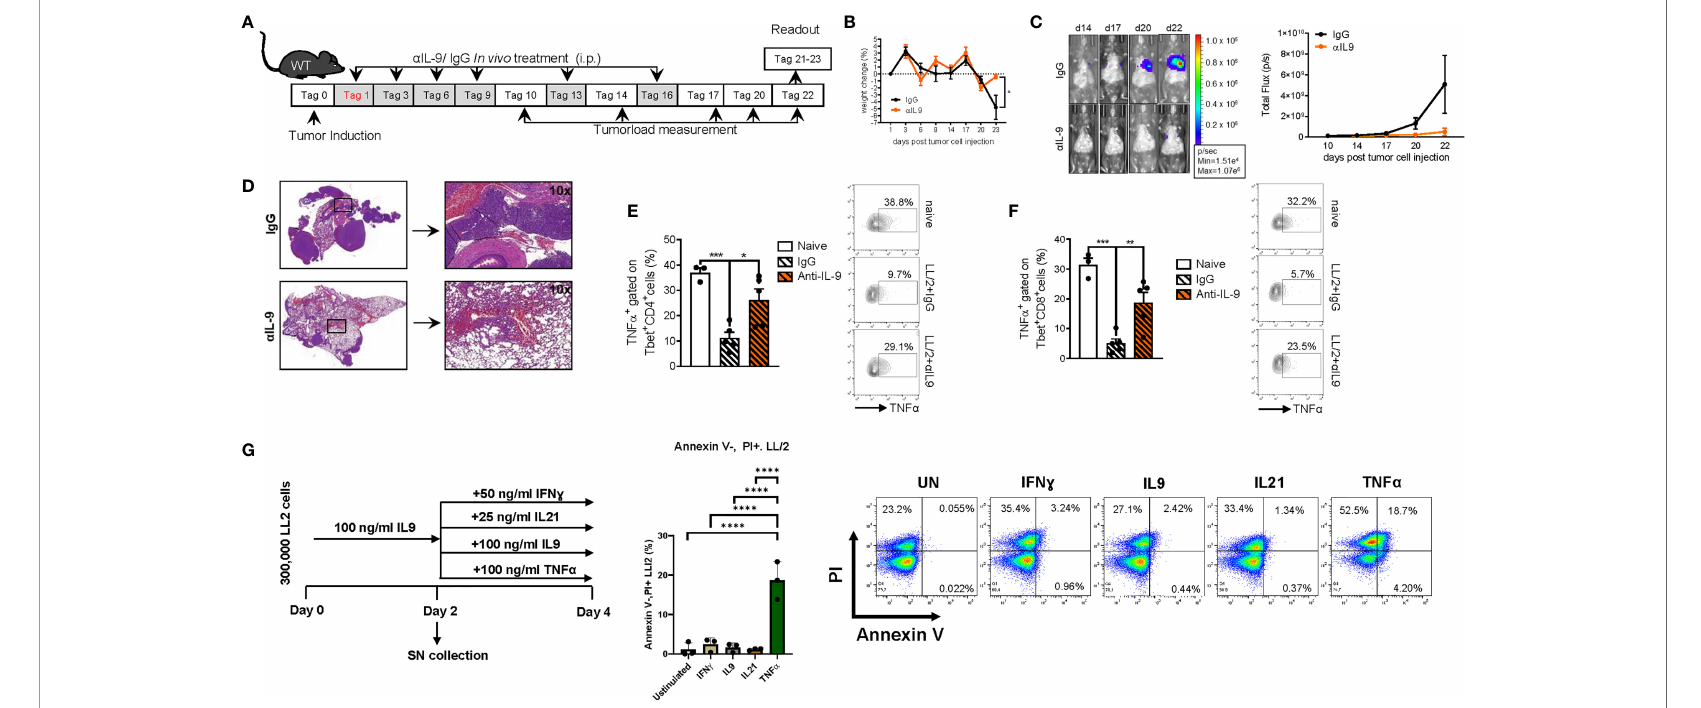
FIGURE 8 | Anti-IL9 antibody treatment inhibits lung tumor development. (A) Experimental design: BL/6 WT mice were intravenously injected with LL/2 cells on day 0. Mice were then treated intraperitoneally (i.p.) with anti ( a )-IL9 antibody or IgG2a isotype control on days 1, 3, 6, 9, 13 and 16 after tumor induction. Overall survival rate of a IL9 antibody or IgG2a isotype control treated mice. Survival rate on the right handside. (B) Monitoring of body weight changes of BL/6 WT mice injected i.v. with LL/2 cells). (C) Tumor load was analyzed via bioluminescence-based imaging system on the indicated days. The experiment ended on day 23. Representative in vivo images of lung tumor load analysis at days 14, 17, 20 and 22 in WT mice treated with a IL9 antibody or IgG2a isotype control (representative of 3 independent experiments) are shown. and lung tumor load (Total fl ux=photons/second) (Day10-20 n IgG2a+LL/2 = 5, n a IL-9+LL/2 = 5; day22 n IgG2a+LL/2 = 5, n a IL-9+LL/2 = 4) were quanti fi ed. (D) Representative H&E staining of WT mice treated with a IL9 antibody or IgG2a isotype control (scale bar=200 µm). (E) Flow cytometry analysis of TNF a positive cells (%) gated on Tbet and CD4 co-expressing cells (nnaive=3; nIgG2a+LL/2 = 5; n a IL-9+LL/2 = 5). (F) Flow cytometry analysis of TNF a positive cells (%) gated on Tbet and CD8 co-expressing cells (nnaive=3; nIgG2a+LL/2 = 5; n a IL-9+LL/2 = 5). (G) Experimental design is similar to the A549 cell line culture whereby LL/2 were pre-cultured for 2 days of IL9 (100 ng/ml) and then further cultured for 2 days unstimulated or cultured with either IFN ɣ , or IL9, IL21 or TNF a , respectively. Annexin V(AnnV)/PI fl ow cytometry analysis of IL9 pre-treated LL/2 cells at the end of the cell culture, A representative dot plot is showed for each group. The data were statistically analyzed with one-way ANOVA, and showed with mean ± SEM. n=3 per group. *P < 0.05; **P < 0.01; ***P < 0.001; ****P <